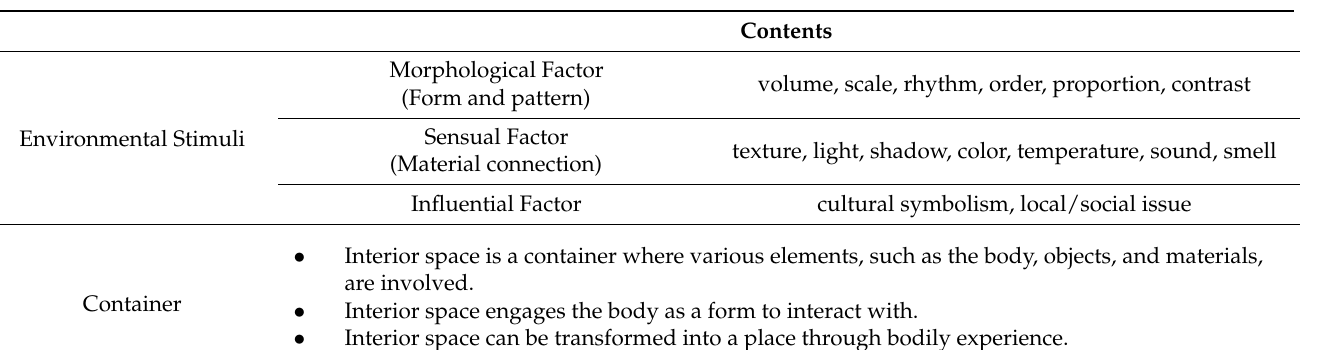
Table 1. Characteristics of interior space. Source: author’s